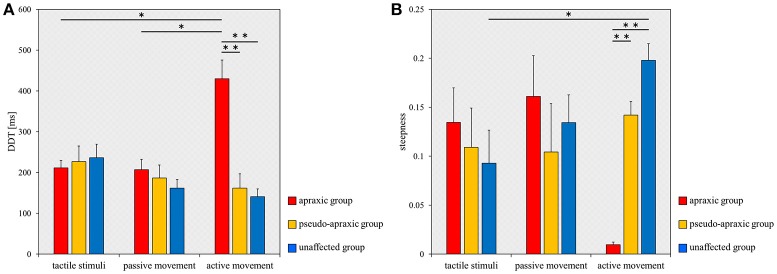
Mean DDT or steepness under each stimulus condition in each group. DDT, the delay detection threshold for the detection of delayed visual feedback. Steepness, the steepness of the probability curve for the detection of delayed visual feedback. The horizontal axis shows each stimulus condition. Blue bar, unaffected group (n = 9); yellow bar, pseudo-apraxic group (n = 6); and red bar, apraxic group (n = 7). Error bars represent standard error of the mean. (A) Comparison of the mean DDT of each group in each stimulus condition. (B) Comparison of the mean steepness of each group in each stimulus condition. *p < 0.05; **p < 0.01, Bonferroni-corrected.